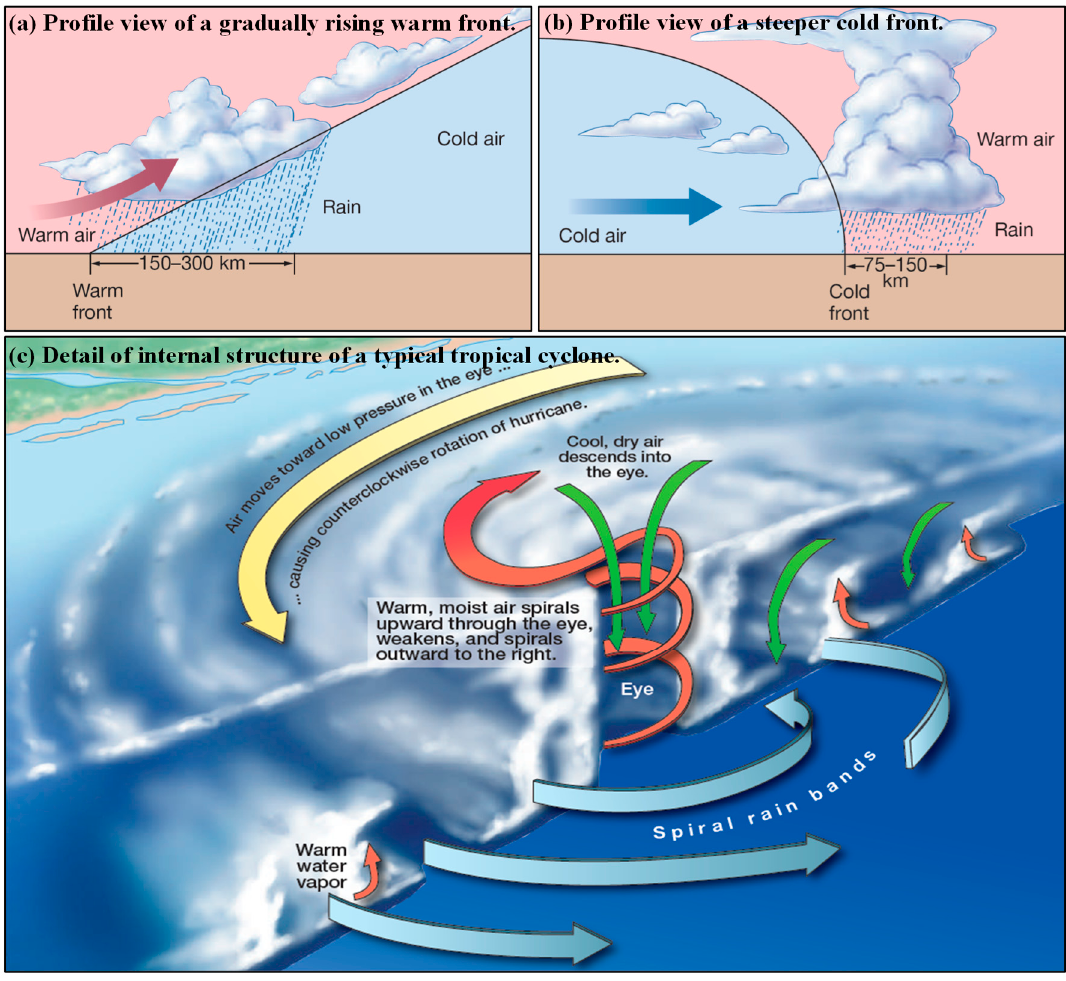
Figure 1. Warm, cold fronts, and typical internal structure of a tropical cyclone [37]. Profile (side) view through ( a ) a gradually rising warm front and ( b ) a steeper cold front, with both fronts, rising warm air, causing precipitation; ( c ) enlarged cut-away view of a tropical cyclone showing its components, internal structure, and winds.